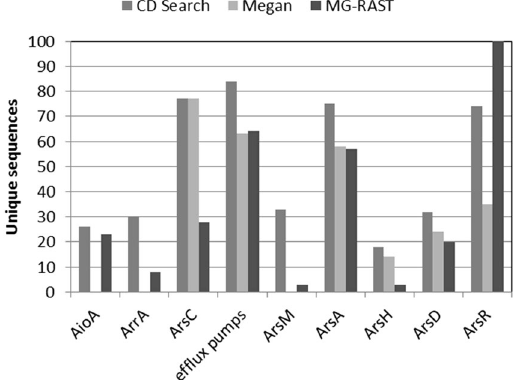
Figure 4. Diversity of arsenic metabolism related proteins, based on NCBI CDD Search, MEGAN, and MG- RAST annotation. Efflux pumps include both Acr3 and